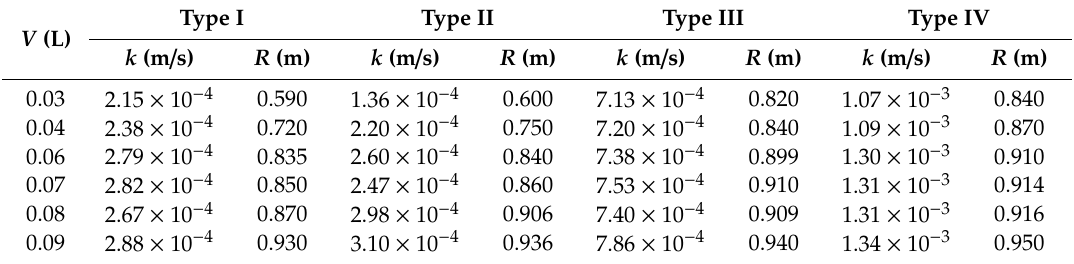
Table 3. Hydraulic conductivity values and the corresponding radii of influence relative to each injection volume of the slug test and for each